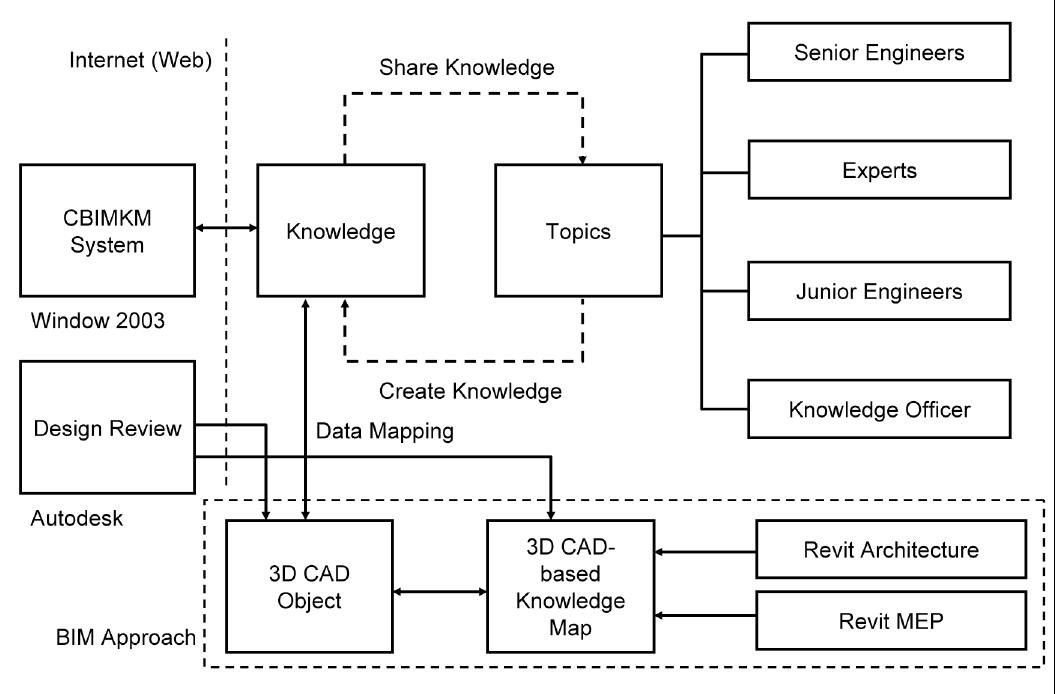
Fig. 2. The concept of the 3D CAD-based knowledge maps using BIM